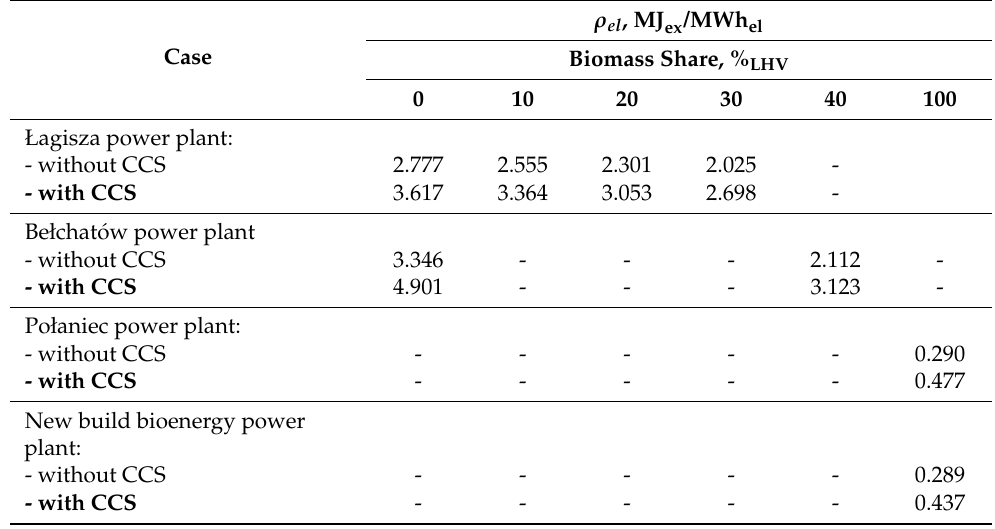
Table 7. Specific thermo-ecological cost of net electricity production for the analyzed power plants.